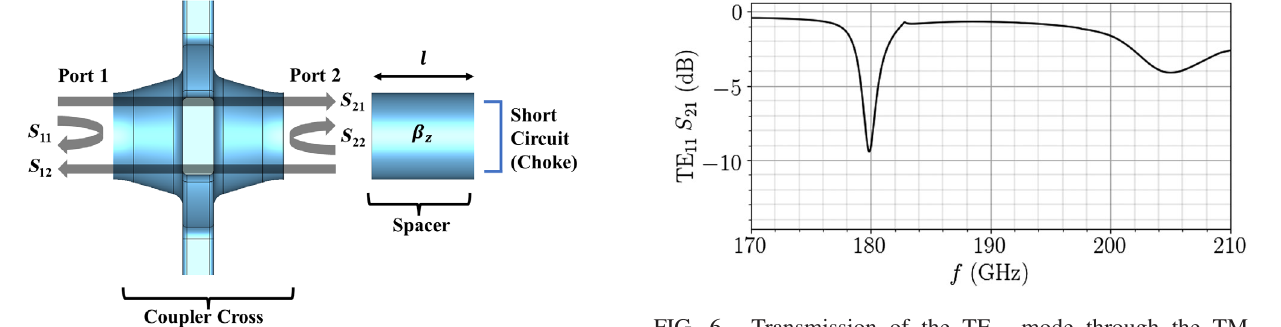
tion scheme, showing the coupler cross isolated from the idealized rf